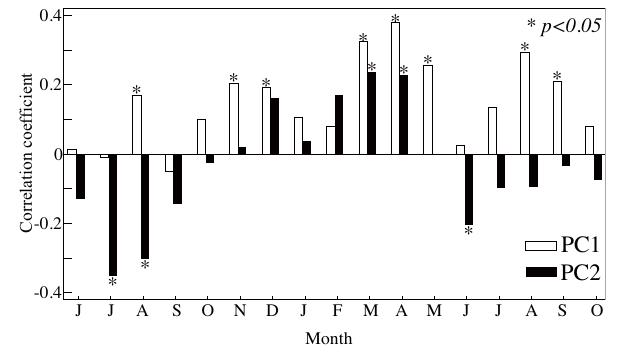
Fig. 2. Correlations between principal components and the mean March–May land temperature over the 35–40 ◦ E, 125–140 ◦ N study